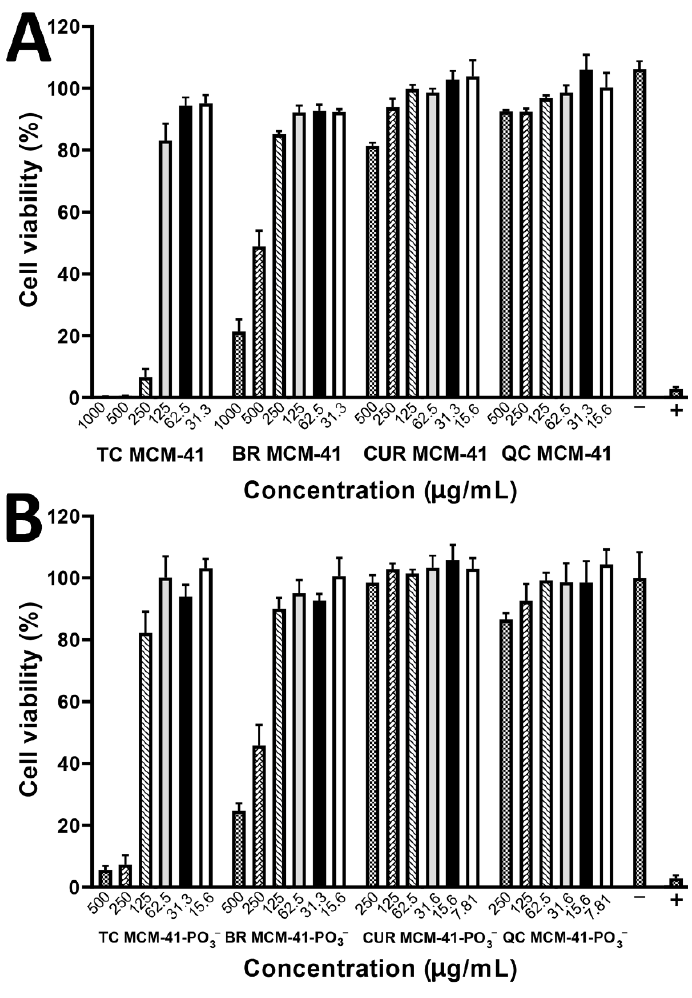
Figure 7. Assessment of the effects of SrtAI-loaded (TC, CUR, QC, and BR) ( A ) MCM-41 and ( B ) MCM-41-PO 3 − MSNs on HEK-293 cell viability after 24 h incubation using a resazurin cell viability assay. Data are expressed as mean ± SD ( n = 3) ( p > 0.05). Results are demonstrated as a reduction percentage of viable cells and compared with non-treated cells.